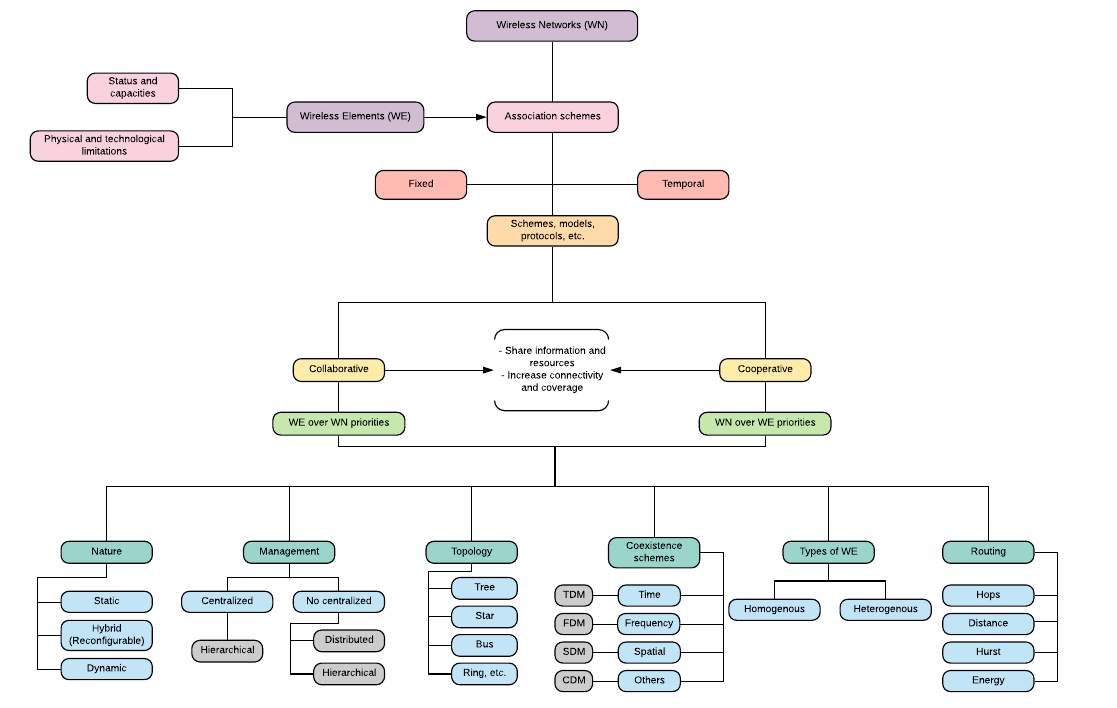
Figure 1. Concepts and aspects of Wireless Communication